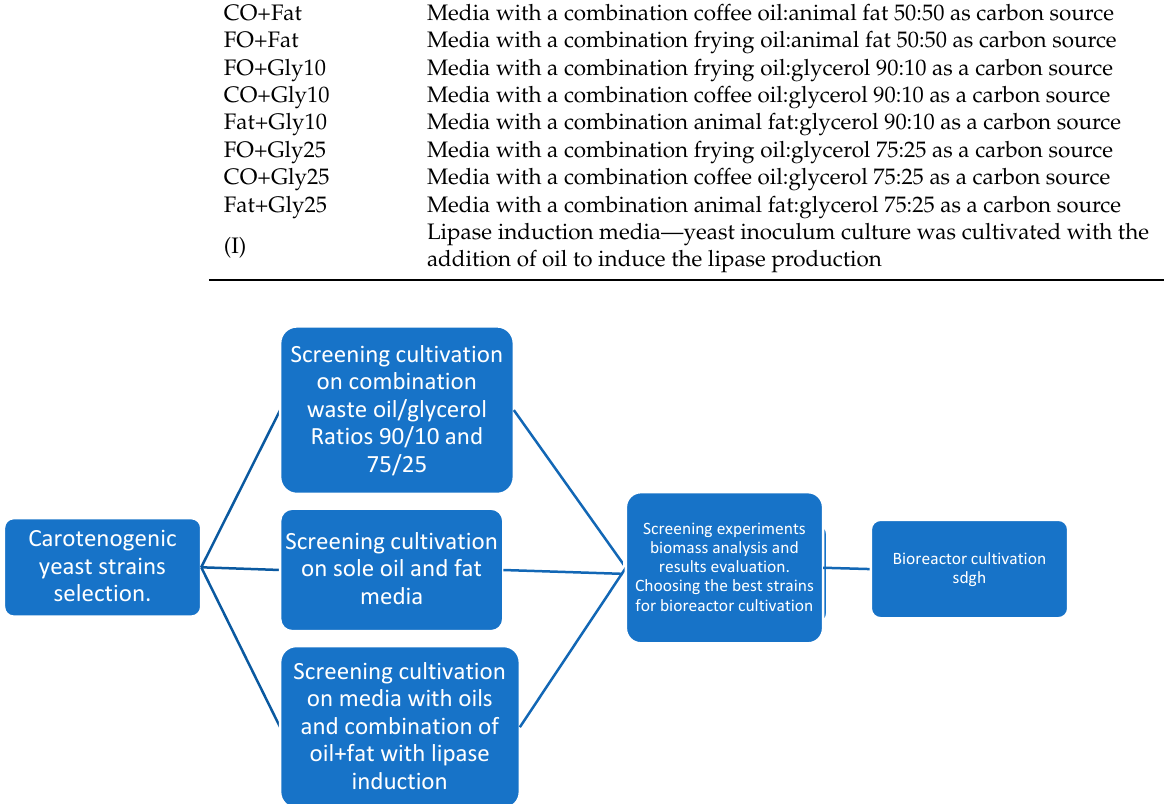
Figure 1. Experimental scheme diagram.